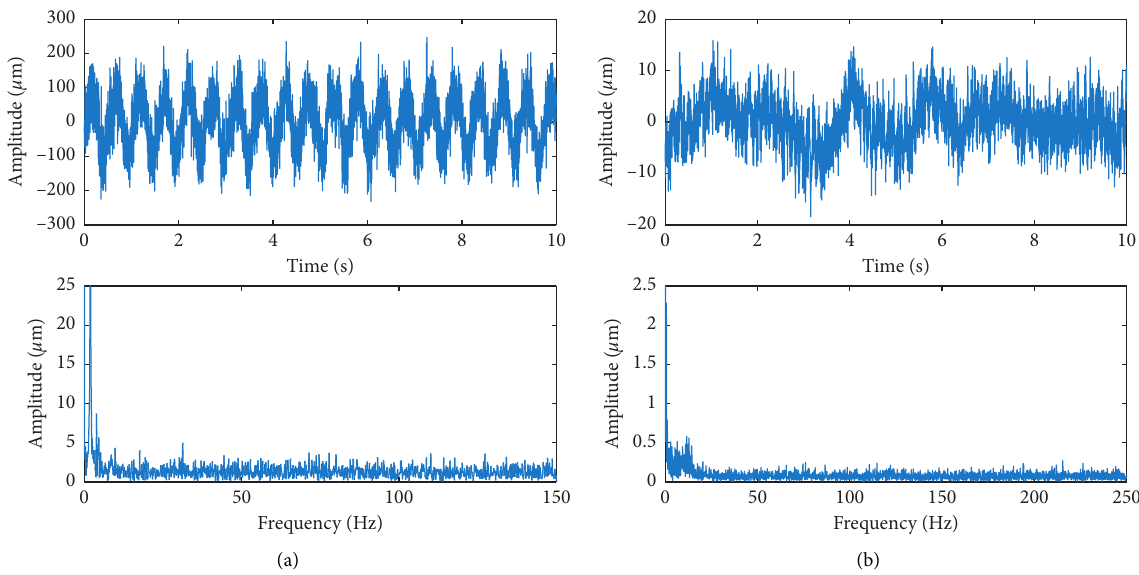
Figure 4: Actual signal of turbine. (a) Y -direction swing signal at the flange. (b) Vibration signal at the draft tube.